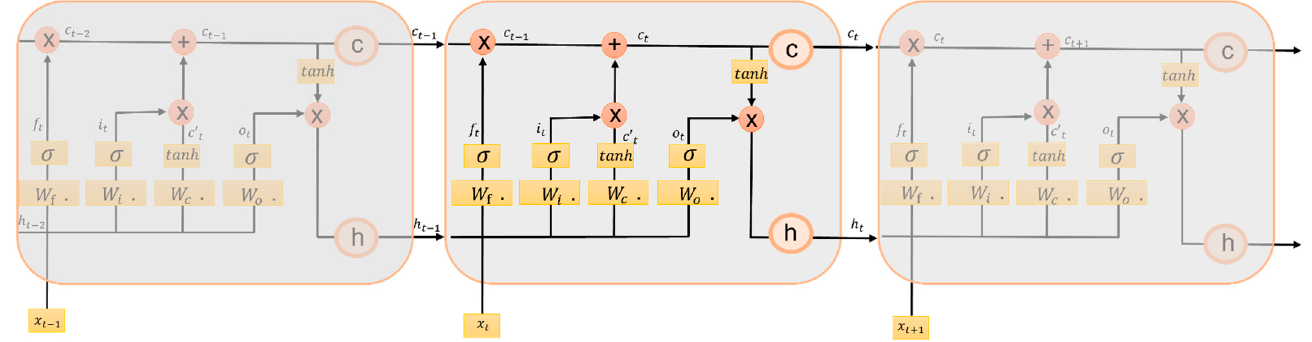
Figure 1. Structure of long short-term memory (LSTM) memory cell, including the forget, input, and output gates.